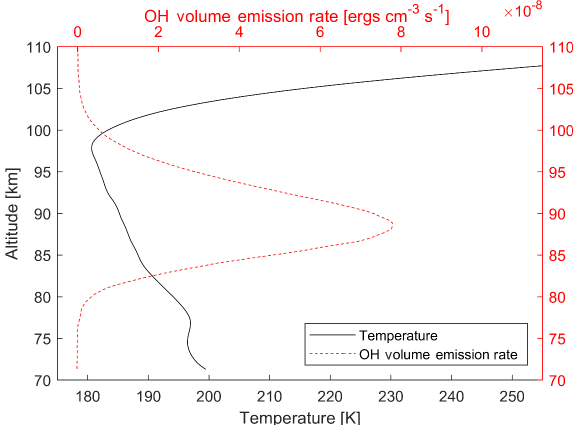
Figure 1. Example of a typical temperature profile (black line) of the airglow layer and the VER (dashed red line) from the SABER satellite showing the variation of temperature through the emission region. This specific measurement is a zonal mean and monthly av- erage from July 2016 between the latitudes of 20 and 30 ◦ N for the (cid:49)v = 2 bands from the upper-state vibrational levels 8 and 9. An erg is equivalent to 10 − 7